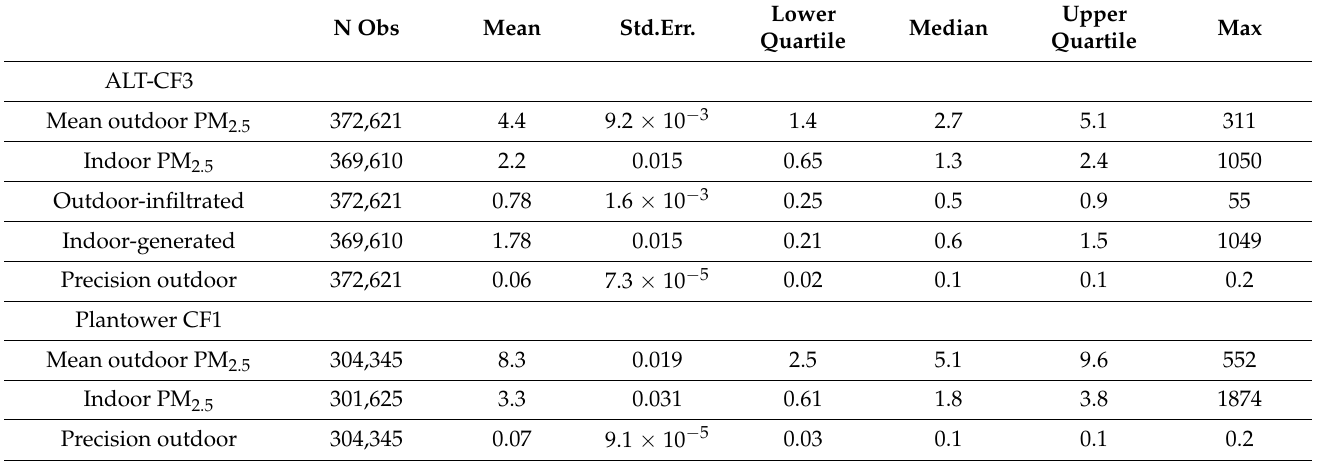
Table 1. PM 2.5 ( µ g/m 3 ) and associated precision at the Menlo Park site using the ALT-CF3 and Plantower CF1